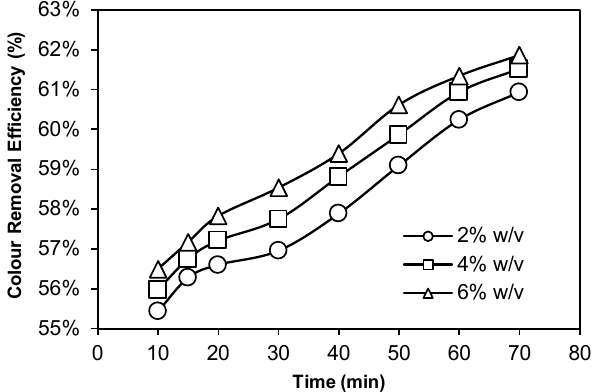
Table 2. The kinetic parameter of Pb(II) ion and color adsorption onto Si-Kit at several of adsorbent